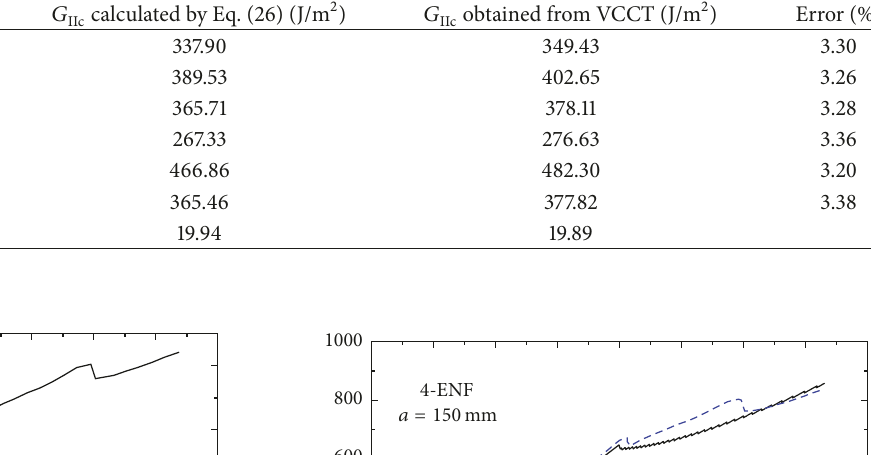
Table 2: Results of critical load 𝑃 𝑐 and fracture toughness 𝐺 IIc .